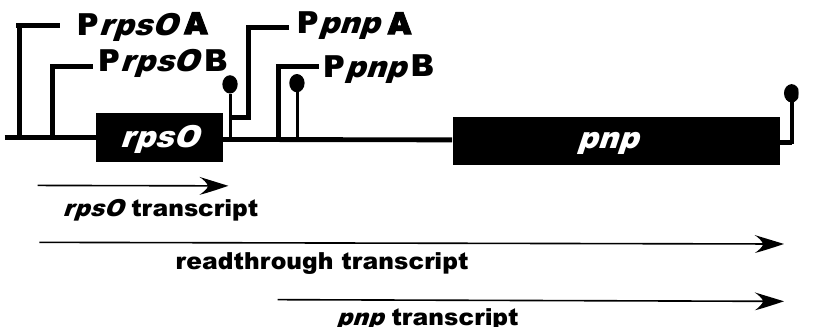
Figure 1. Schematic representation of the Streptomyces coelicolor rpsO–pnp operon. P rpsO A, B and P pnp A, B represent the upstream and intergenic promoters found in S. coelicolor , respectively. The ball-and-stick structures immediately following rpsO and pnp represent rho-independent transcription terminators. The ball-and-stick structure just upstream of pnp represents the intergenic hairpin which is cleaved by RNase III. The diagram is not drawn to scale.